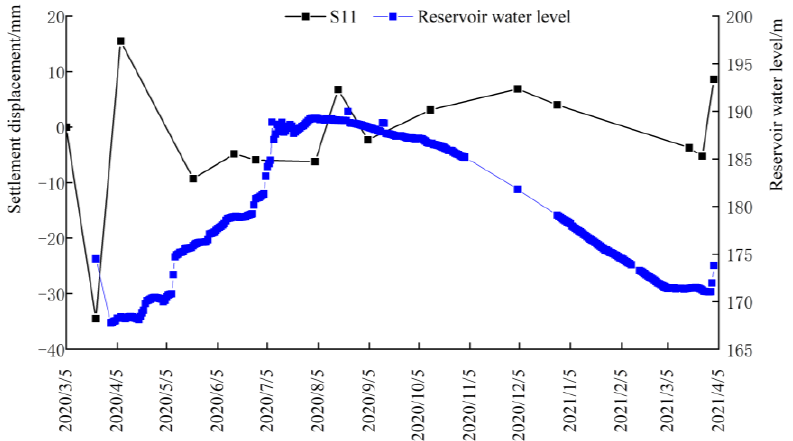
Figure 10. 1 # section settlement displacement duration curve (downward is +, upward is − ).